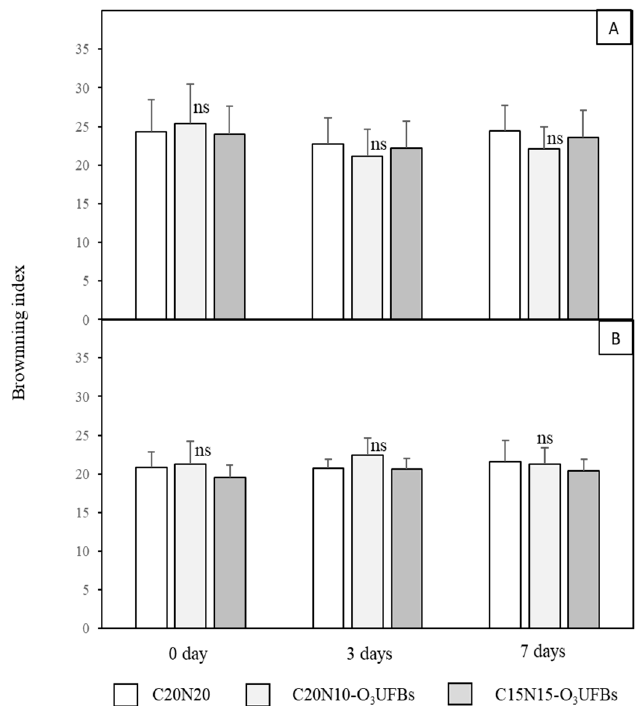
Figure 5. Mesocarp browning index of trimmed coconuts dipped in C 20 N 10 -O 3 UFBs and C 15 N 15 - O 3 UFBs compared with C 20 N 20 when stored at 2 °C for 0 days (before storage) ( A ) and 30 days ( B ). After storage, all coconut fruits were transferred to 8–10 °C for 7 days, and the browning index was evaluated on days 0, 3, and 7. ns: not significantly different.